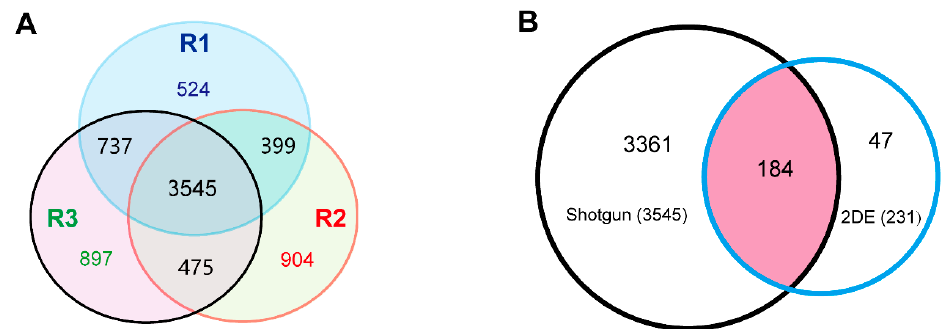
Figure 4. High-throughput proteomics analysis of the 6M TKS roots. Three shotgun proteomics were performed to determine the large-scale protein profiles in the 6M roots, and finally identify 3545 shared proteins in the three experiments ( A ) The blue, yellow, and pink circles represent for the first, second, and third biological replicates. Among these proteins, 184 proteins could also be detected from the 2-DE gel ( B ). The pink area represents for the 184 shared proteins that were identified by both the 2-DE and shotgun based proteomic methods.